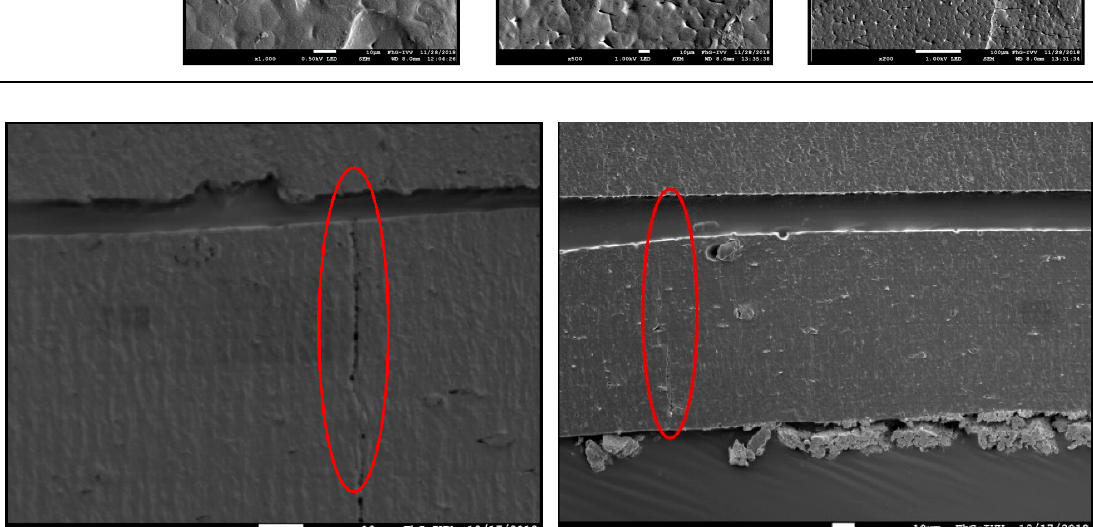
Figure 18. Scanning electron microscopy (SEM) pictures of pure PHBV film with defects (marked in red). Left : magnification ×1000, right : magnification ×500; red ellipse: cracks in the layer.